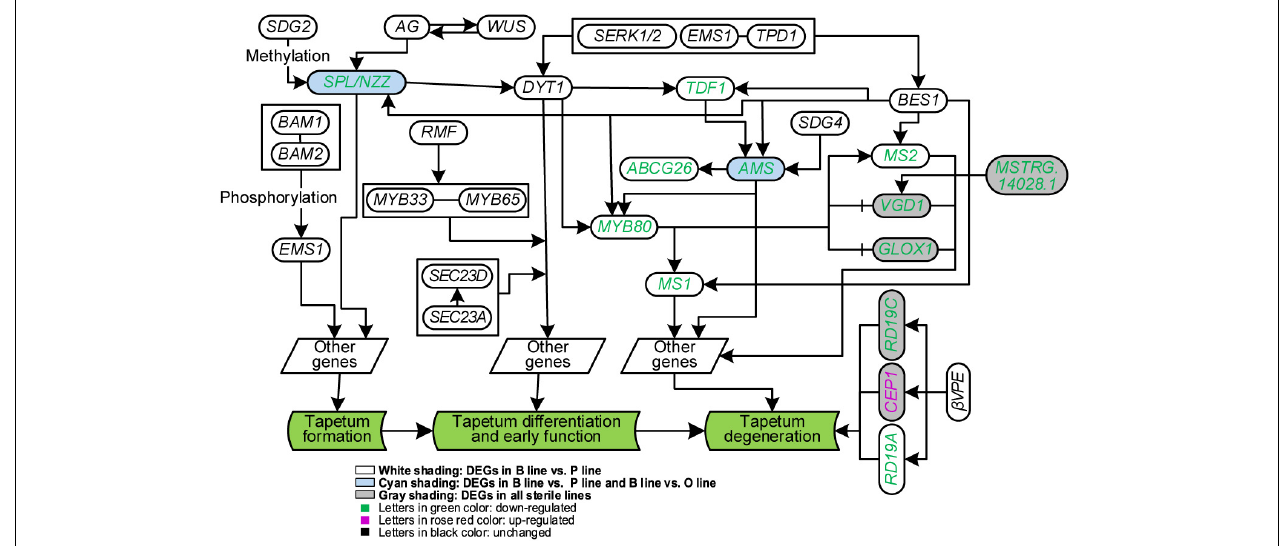
FIGURE 5 | Analysis of genes in tapetum development of Brassica campestris . Genes in the same box were worked together to regulate downstream genes. B line, the fertile line ‘ Bcajh97-01B ’; P line, the Polima cytoplasmic male-sterile line ‘ Bcpol97-05A ’; O line, the Ogura cytoplasmic male-sterile line ‘ Bcogu97-06A .’ SDG2/4, SET domain protein 2/4; BAM1/2, β -amylase 1/2; AG, agamous; WUS, wuschel; SPL/NZZ, sporocyteless/nozzle; RMF, reduced male fertility; MYB33/65, MYB domain protein 33/65; DYT1, dysfunctional tapetum 1; SERK1/2, somatic embryogenesis receptor-like kinase 1/2; EMS1, excess microsporocytes 1; TPD1, tapetum determinant 1; TDF1, defective in tapetal development and function 1; ABCG26, Adenosine triphosphate (ATP)-binding cassette subfamily G 26; AMS, Aborted microspores; MYB80, MYB domain protein 80; MS1/2, male sterility 1/2; VGD1, Vanguard 1; GLOX1, Glyoxal oxidase 1; CEP1, cysteine endopeptidase 1; β VPE, β vacuolar processing